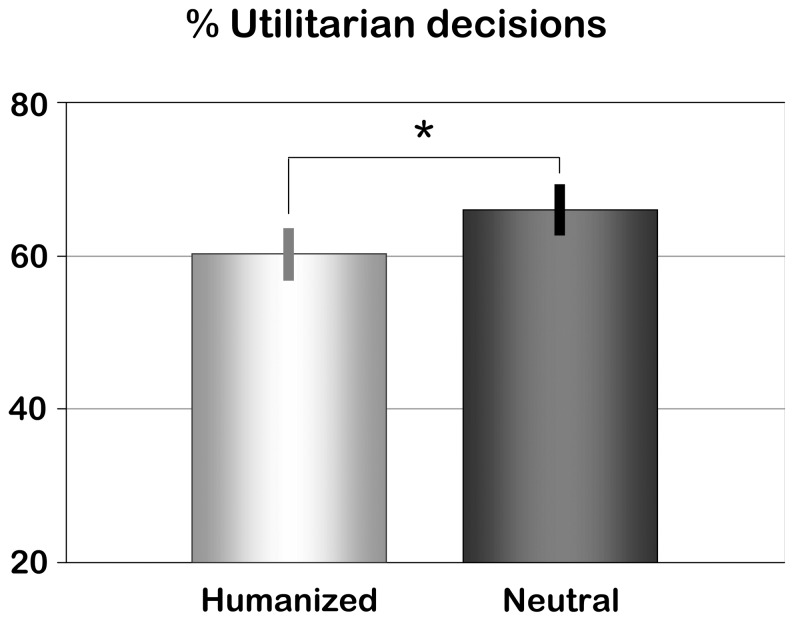
Dilemma decisions.Percentage of utilitarian decisions (i.e., single person is sacrificed to save numerous others threatened by imminent death or injury) in dilemmas involving Humanized or Neutral persons. Error bars denote standard errors of the mean.